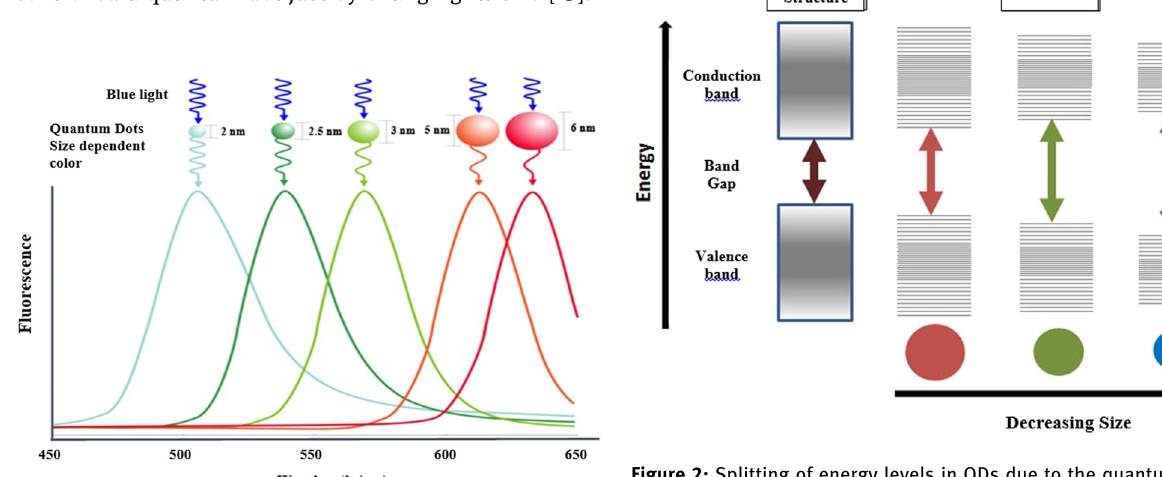
Figure 2: Splitting of energy levels in QDs due to the quantum con fi nement e ff ect, and semiconductor bandgap increases with decrease in size of the nanocrystal [ 14 ]